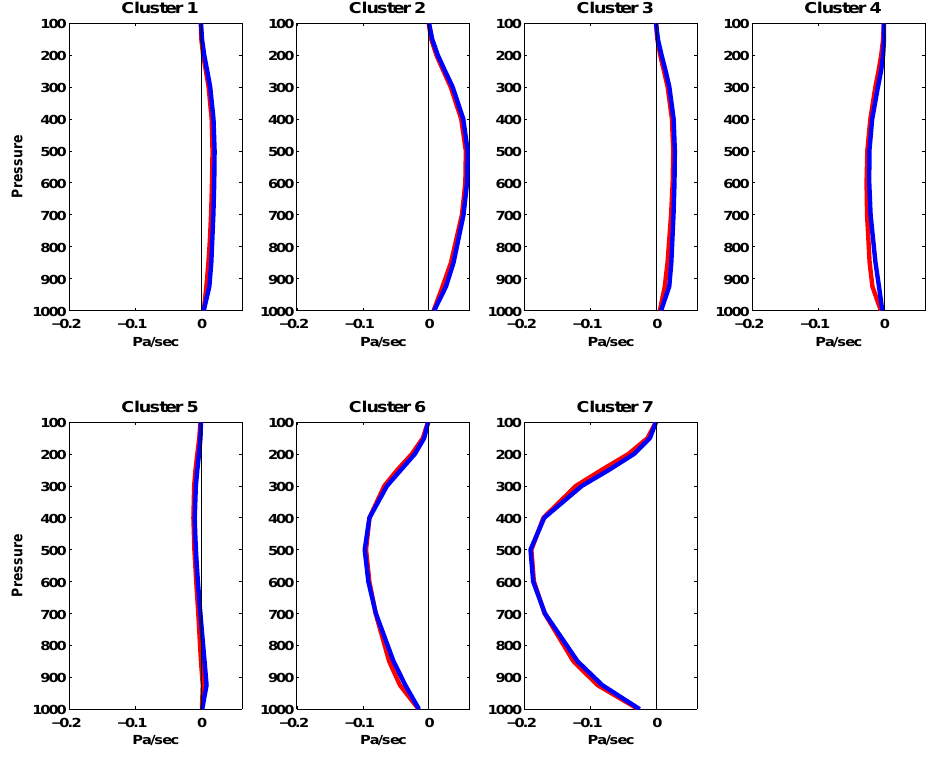
Fig. 17. As in Fig. 14, except for pressure vertical velocity